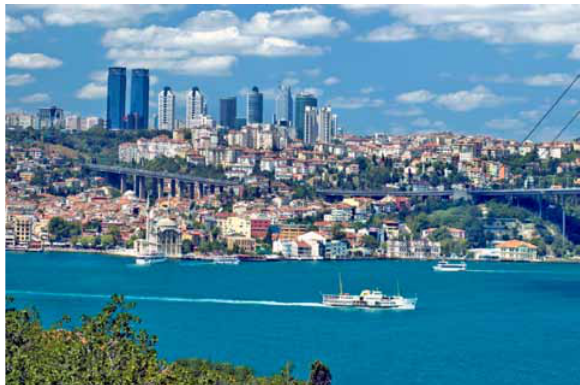
Fig. 1. General view of settlements around of the Bosporus Bridge in European side of İstanbul (wallpaperup